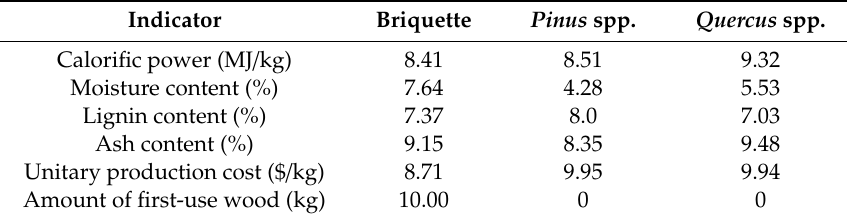
Table 10. Normalized values of the indicators.